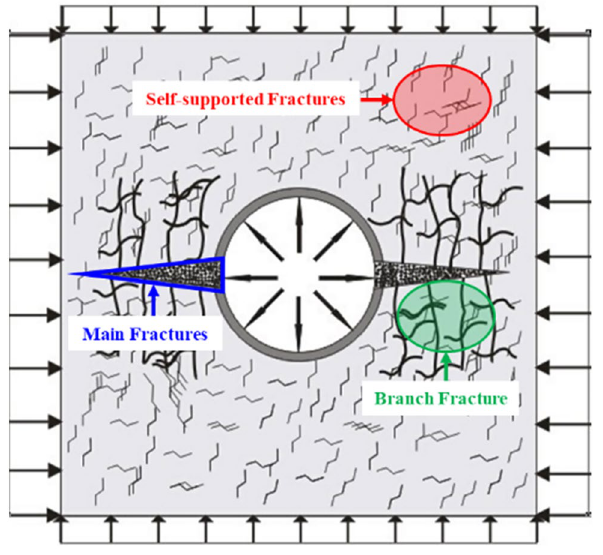
Fig. 1 Three types of fractures in reservoir after fracturing